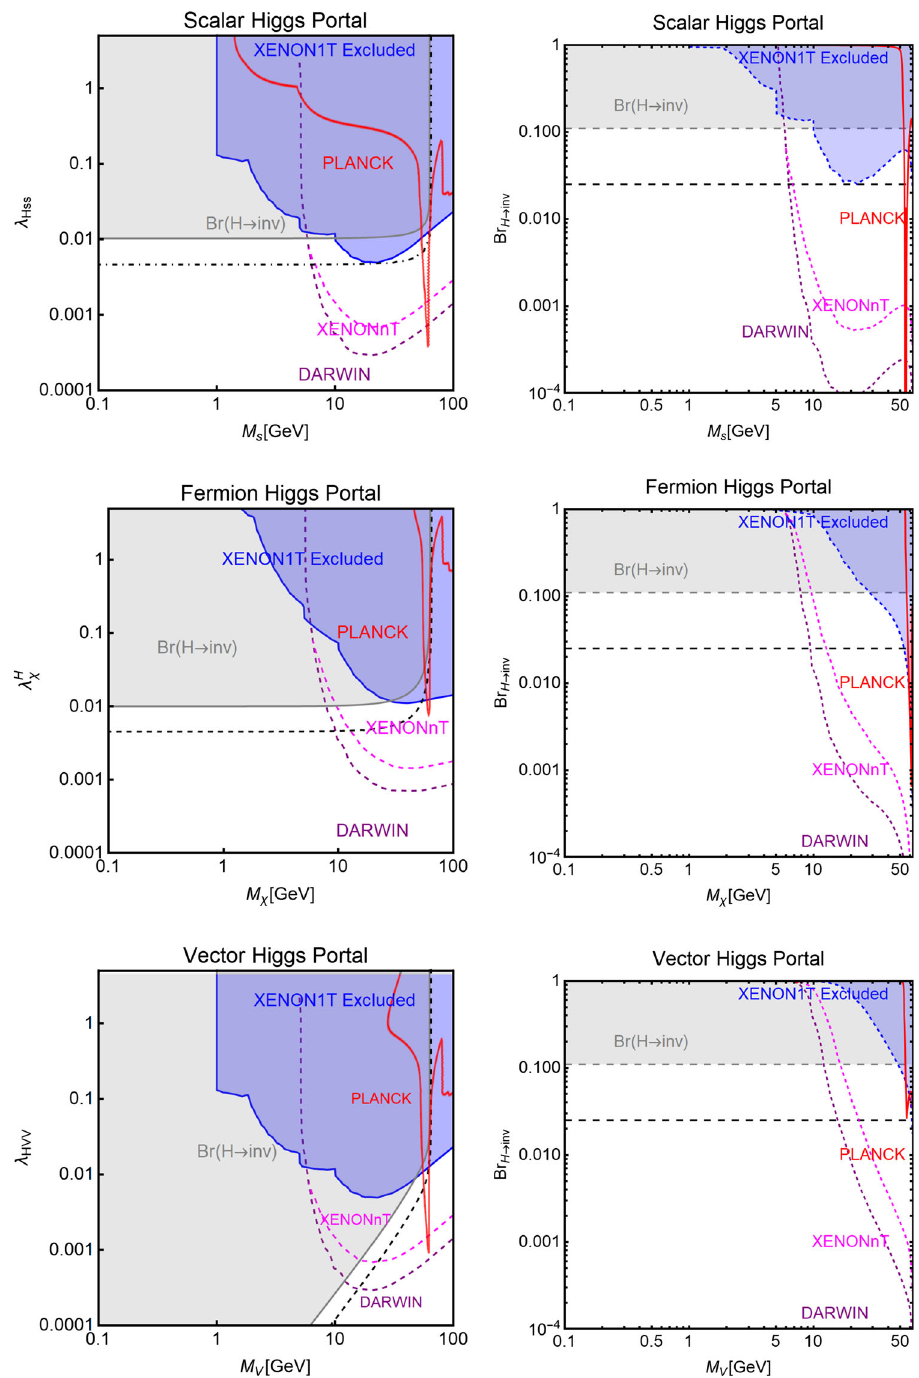
Fig. 1 Constraints in the planes [ M ,λ ] (left panels) and X HXX [ M , BR ( H → X X ) ] (right X panels) for the Higgs-portal DM in the scalar, fermionic and vector cases. The black contours correspond to the measured DM relic density, the blue and gray regions are excluded by direct detection limits from XENON1T and the invisible Higgs decay branching ratio, respectively. The black contour lines correspond to invisible Higgs branching ratios of 2 . 5%, while the magenta and purple contours represent the sensitivity reach of the future experiments XENONnT and